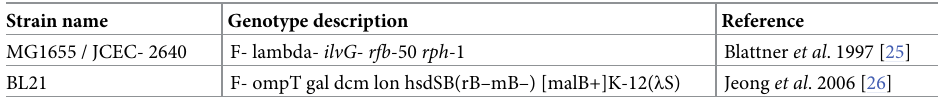
Table 2. E . coli strains used and generated in this